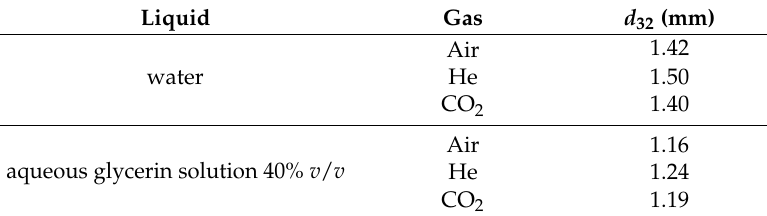
Table 5. Measured mean Sauter diameter ( U GS = 0.01 m/s, d p = 40 µ m).